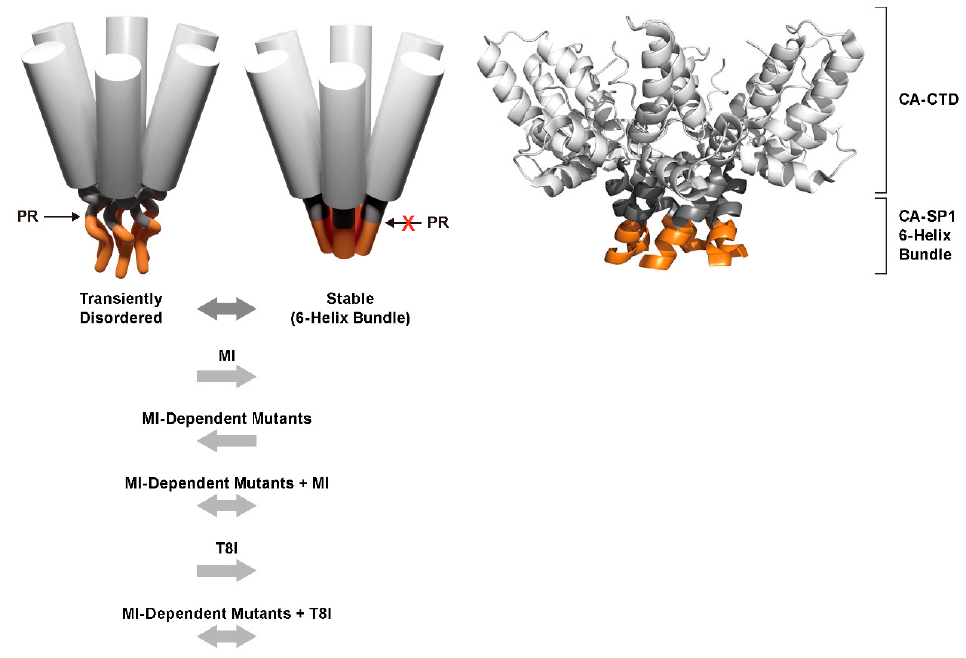
Figure 5. Current model for maturation inhibitor (MI) antiviral activity. The CA-SP1 six-helix bundle region (PDB accession 6BHR) exists in a dynamic equilibrium between stable and transiently disordered states. MI treatment stabilizes the bundle, shifting the equilibrium toward a more rigid structure. Because the CA-SP1 cleavage site is located inside the six-helix bundle, stabilization of the bundle denies PR access to the cleavage site and CA-SP1 processing and maturation are inhibited.